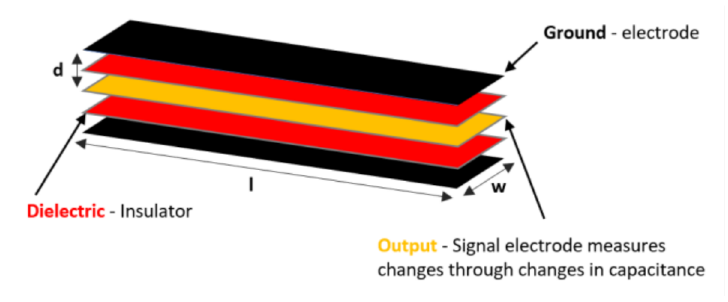
Figure 14. Parallel plate capacitor model of the pressure sensor.